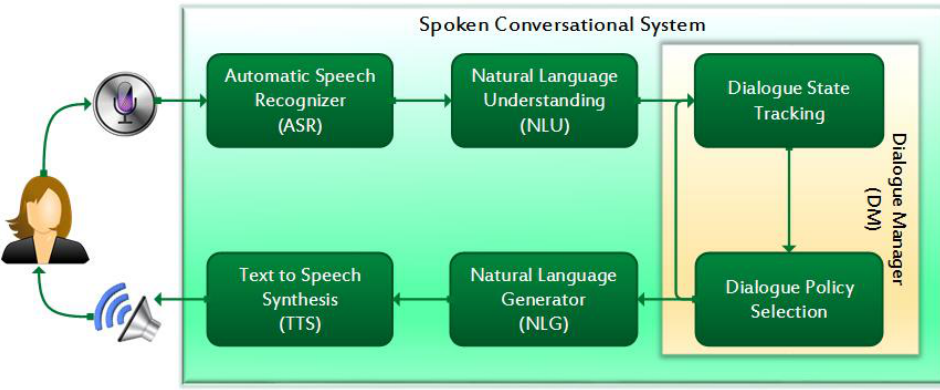
Figure 1. The principal components of a typical conversational system.